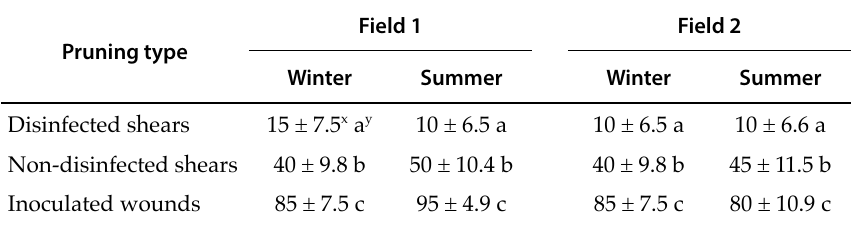
Table 1. Percent (%) Calosphaeria canker incidence on branches of sweet cherry trees 6 months after application of the dif- ferent pruning